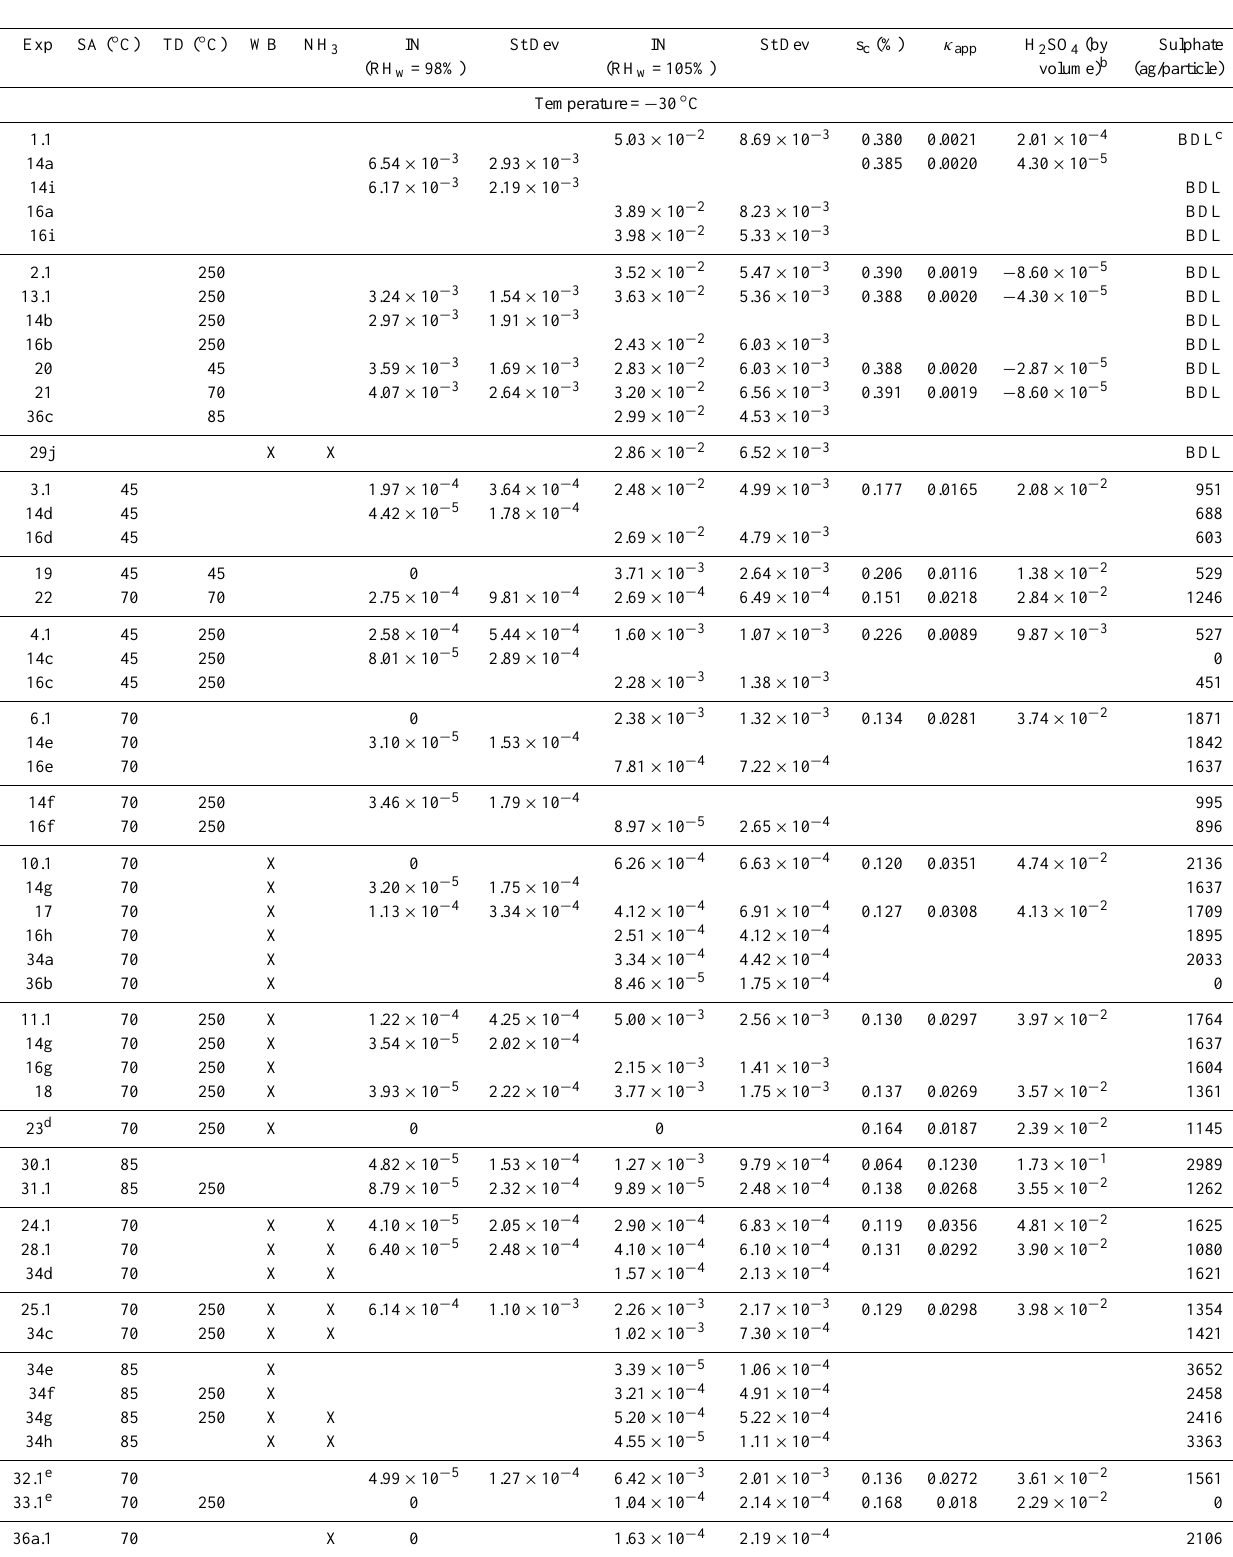
Table 1. IN fractions measured at − 30 ◦ C and − 25 ◦ C for Arizona Test Dust particles subjected to different treatment combinations a , particle hygroscopicity and volume fraction of sulphuric acid estimated from CCN measurements b , and sulphate mass per particle estimated from AMS